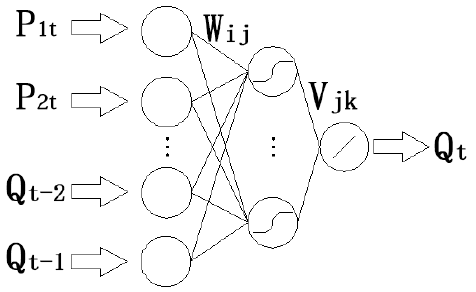
Figure 2. Configuration of a three ‐ layer BP neural network.